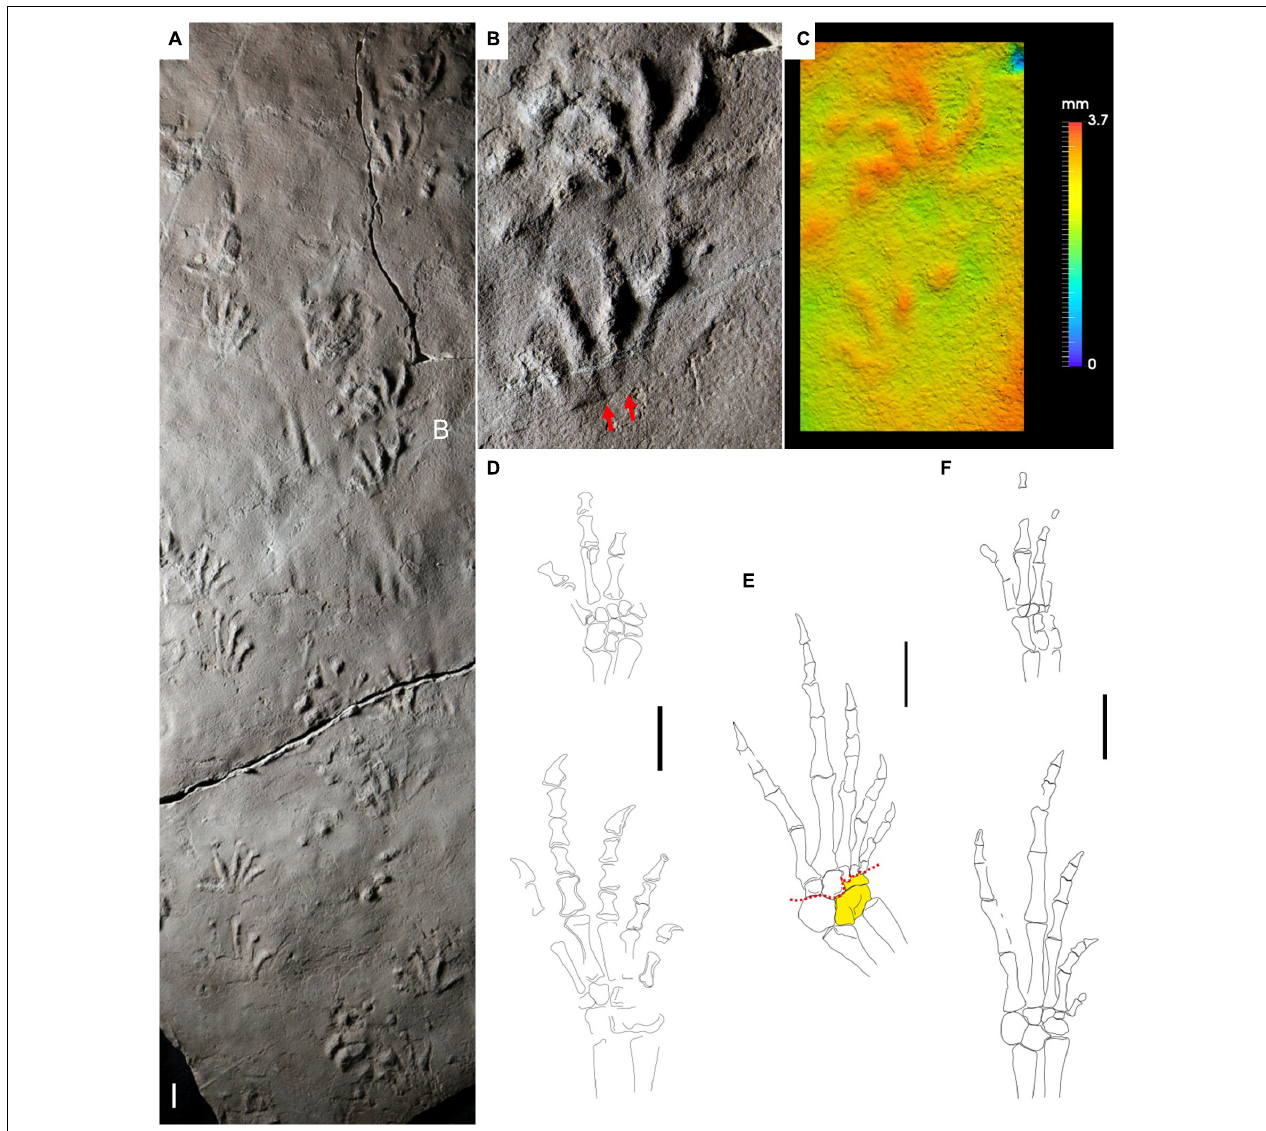
FIGURE 7 | Carboniferous reptile tracks and trackmakers: Varanopus microdactylus (A–C) and bolosaurian parareptiles (D–F) . (A) NSM 997 GF 30.6. Trackway, convex hyporelief. Cape John Formation, Nova Scotia. (B) Enlargement of (A) , left pes-manus couple, convex hyporelief. Red arrows indicate the proximal-lateral digit overlap. (C) False-color depth map of (B) . (D) Erpetonyx arsenaultorum , reconstruction of right pes and left manus, dorsal side. Based on ROM 55402. (E,F) Eudibamus cursoris . (E) Reconstruction of right pes, ventral side. Based on MNG 12895. Astragalus and lateral centrale in yellow (single block). Red dotted lines represent the possible articulations within the tarsus. (F) Reconstruction of left pes and manus, dorsal side. Based on MNG 8852. Scale bars are 1